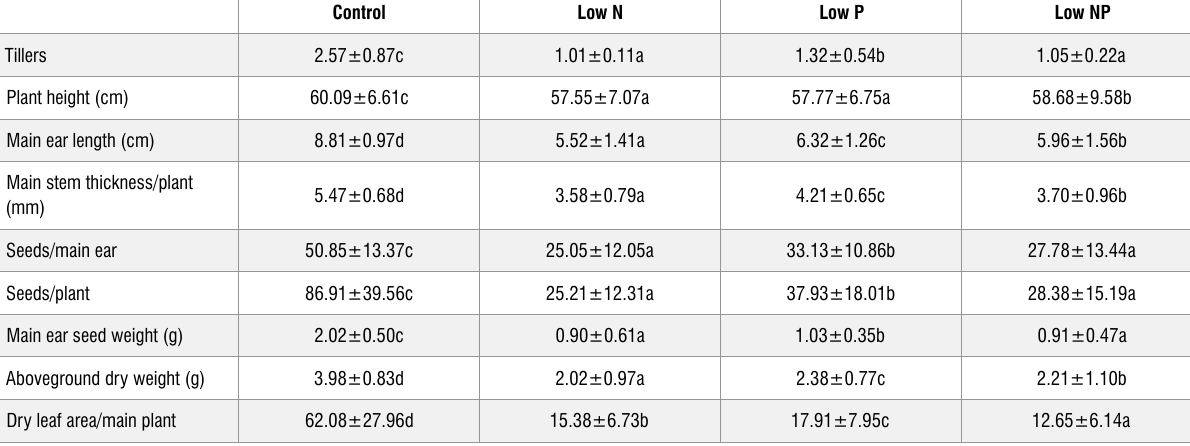
Table 8: Average values for measured characteristics in SST806 with four treatments over two years